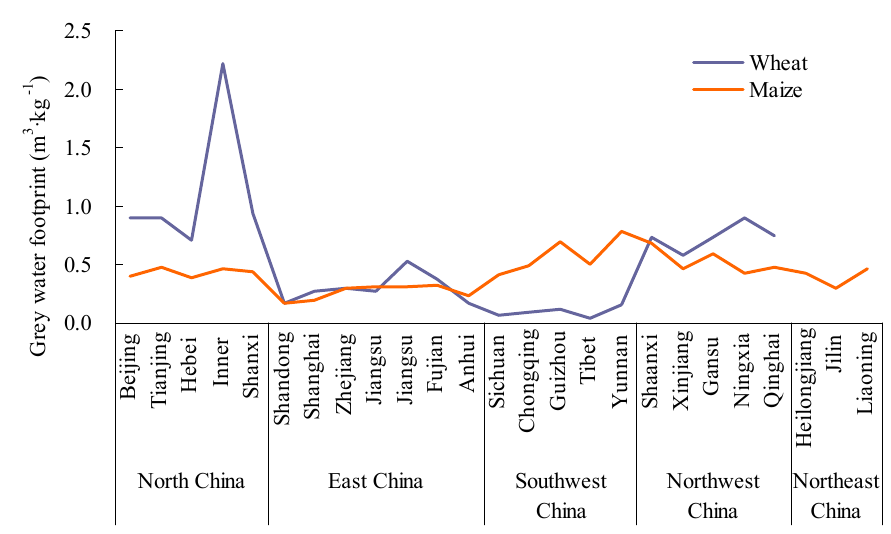
Figure 4. Five-year average of the grey water footprint for wheat and maize production in each province.